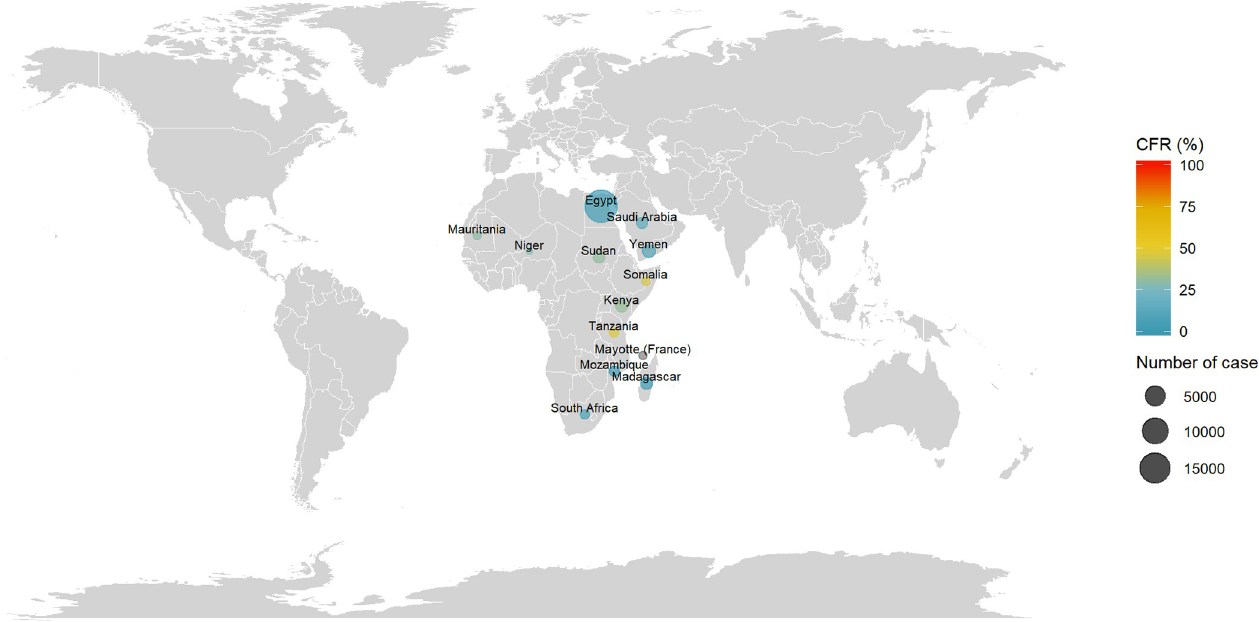
Fig 7. Distribution of number of cases and CFR of Rift Valley Fever. The size of the bubble is proportional with the number of cases reported and the color denotes the level of CFR by country. Note: Maps were generated with the ‘maps’ R package using data from the Natural Earth Project (the 1:50m resolution